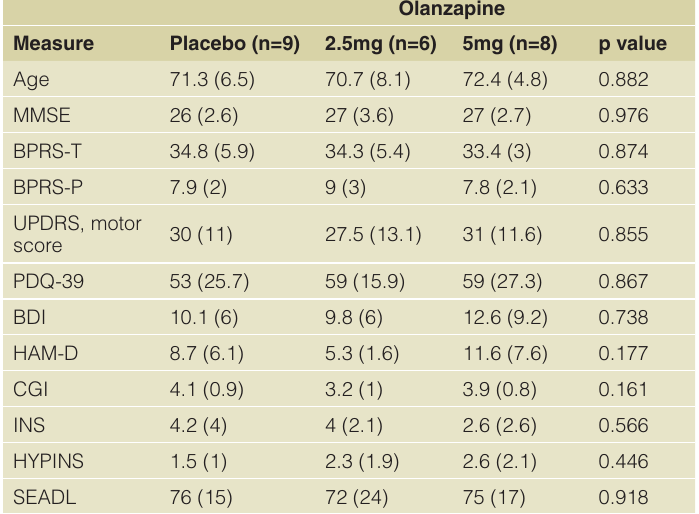
Table 2. Patient characteristics at baseline.